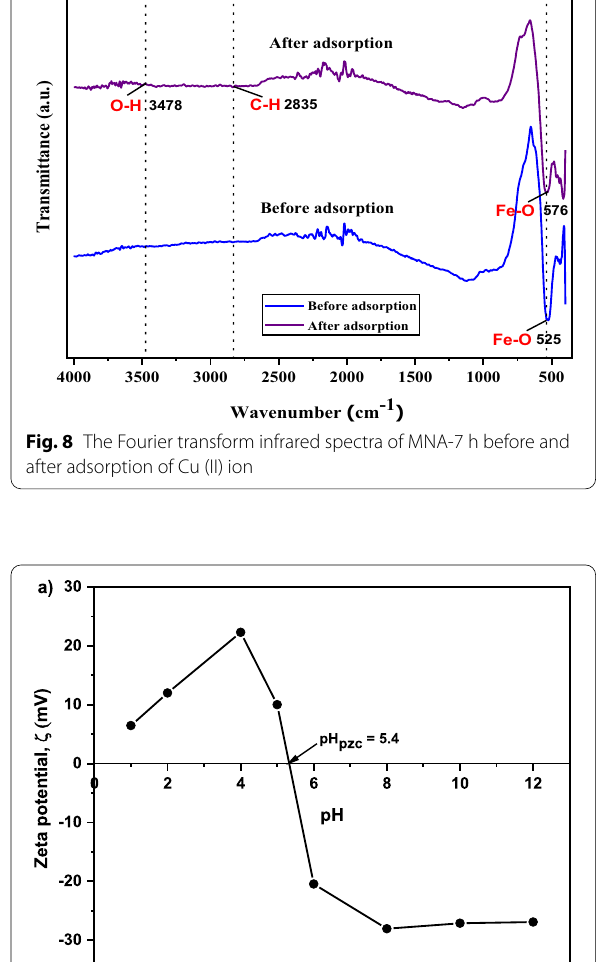
Fig. 9 Zeta potential for pH values of 1, 2, 4, 6, 8, 10, and 12 for MNA-7 h